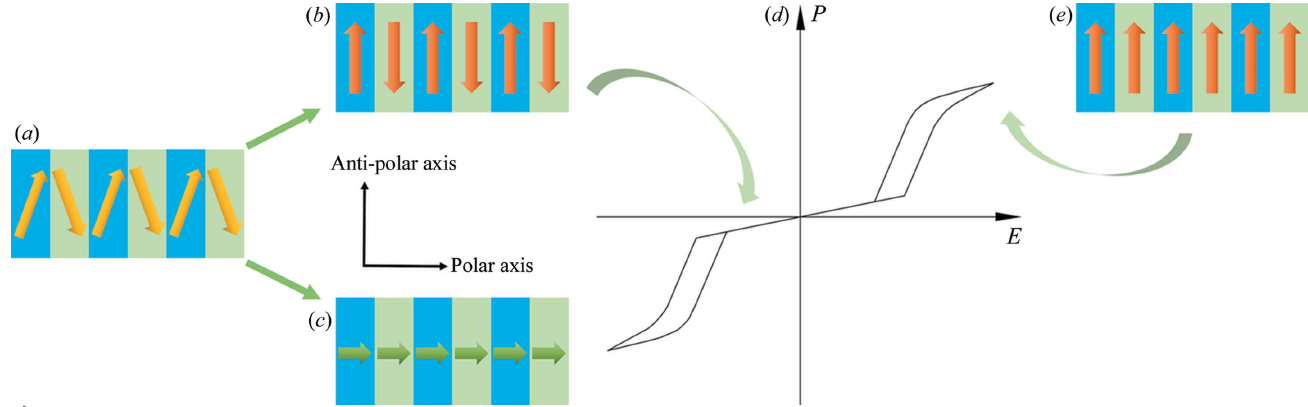
Figure 6 ( a ) Schematic of dipole moments distribution in an AFE crystal crystallized in a polar point group. ( b ) Dipole moment components are in an antiparallel arrangement along the anti-polar axis. ( c ) Dipole moment components are in a parallel arrangement along the polar axis. ( d ) Schematic of double P – E hysteresis loops of an AFE crystal. ( e ) Dipole moments form a parallel arrangement in the field-induced FE